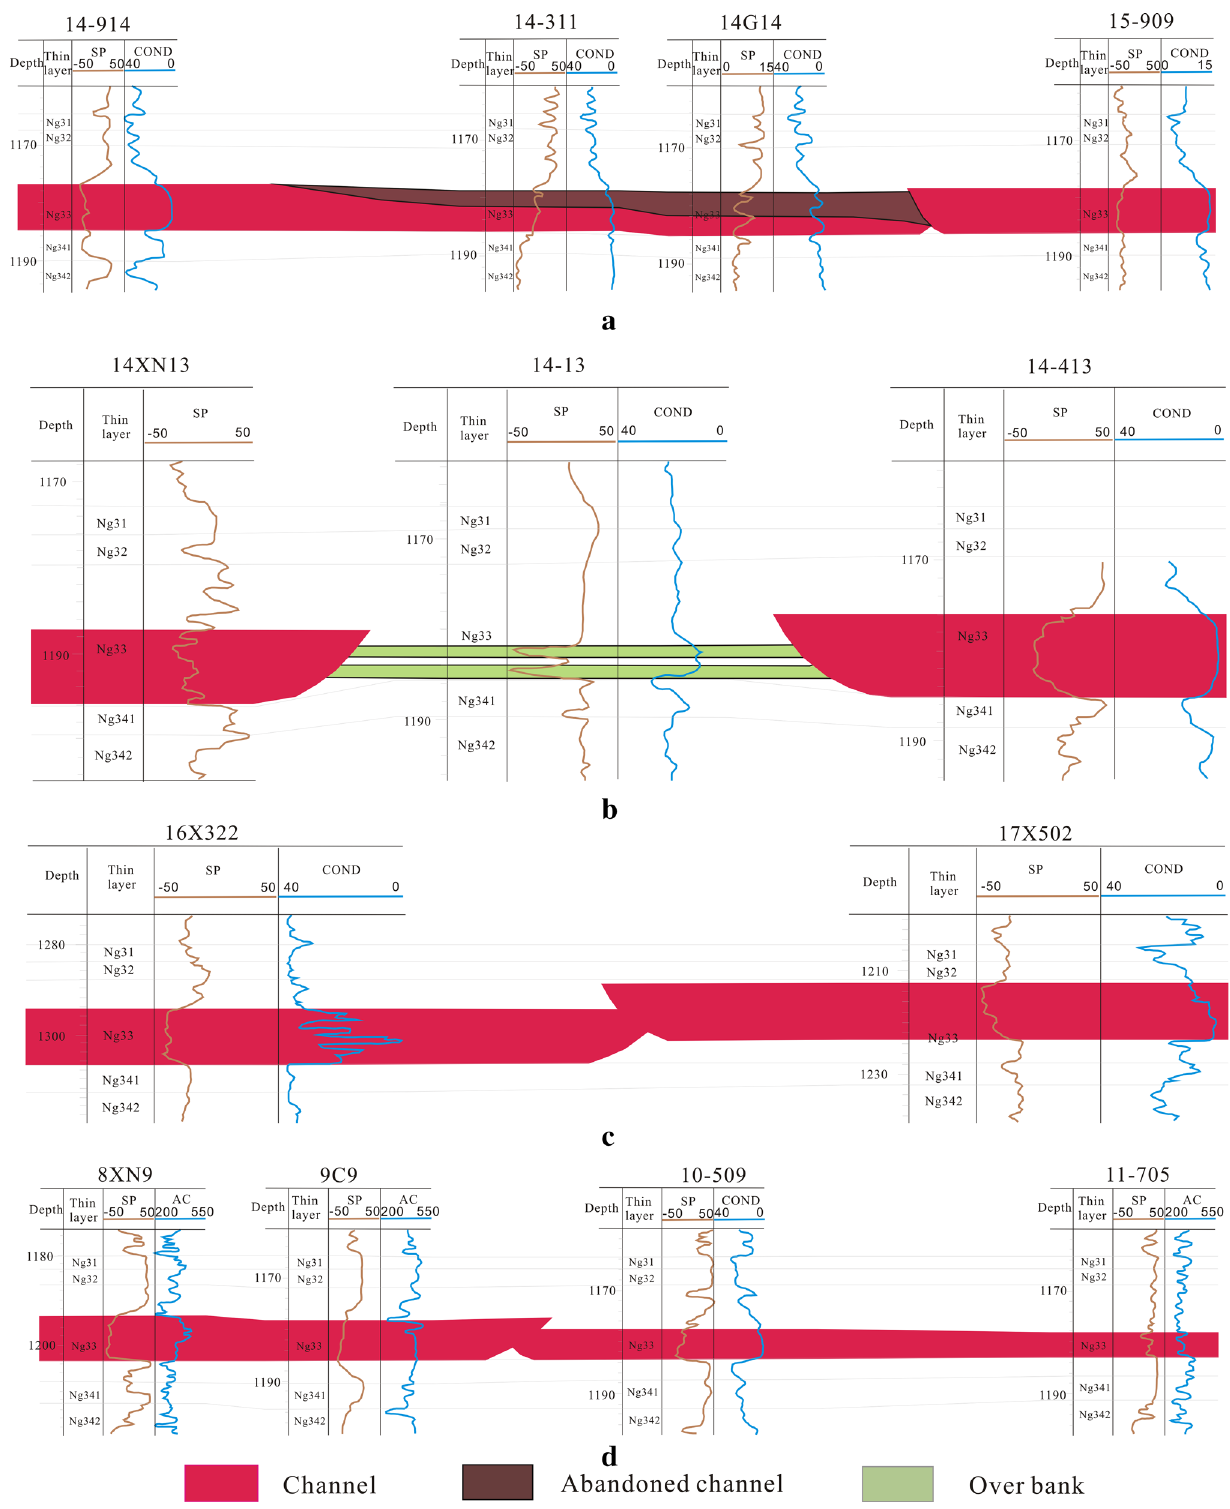
Fig. 4 Four types of single channel belt division signs. a Abandoned channel: final phase of abandoned channel represents the boundary of channel. b Discontinuous deposition between channels. c Height